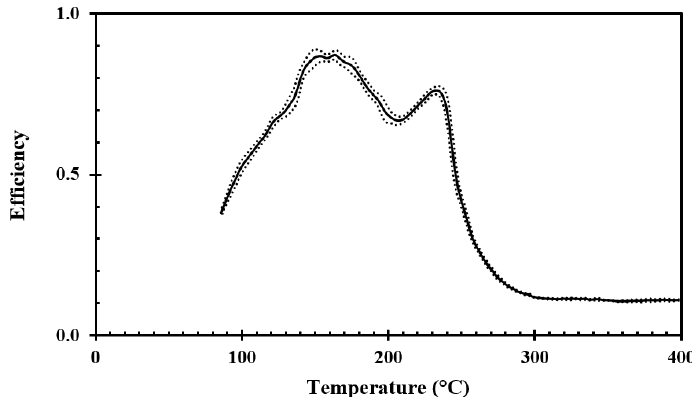
Figure 8. Average cooling efficiency for water droplets impinging onto the stainless steel disc with a surface roughness of Ra 0.4 as a function of temperature ( black ). The dotted lines represent ± one standard deviation, respectively.